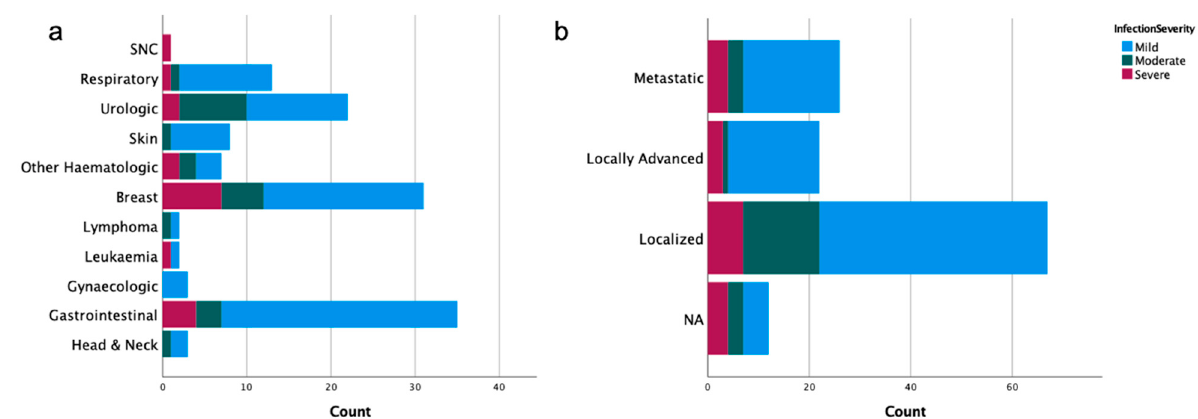
Figure 3. Oncological characteristics distributed by COVID-19 severity: ( a ) type of oncological tumor; and ( b ) stage of the disease.